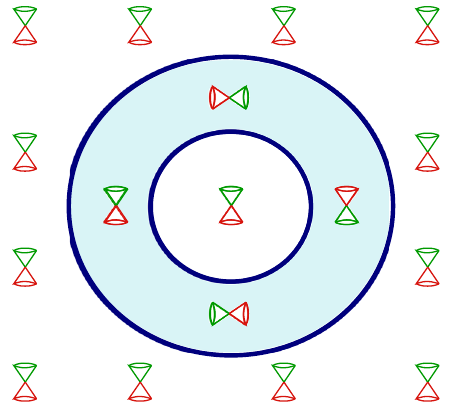
Fig. 5 We represent here the setup described in the text that already shows the difficulty present when trying to build CTCs in a spacetime withatrivialtopology.Theshadedregionrepresentstheregionofabnor- mal behaviour of the lightcones. It seems impossible to regularize the lightcones without removing points from the spacetime, otherwise the metric would need to vanish at some point and hence it would not be a regular